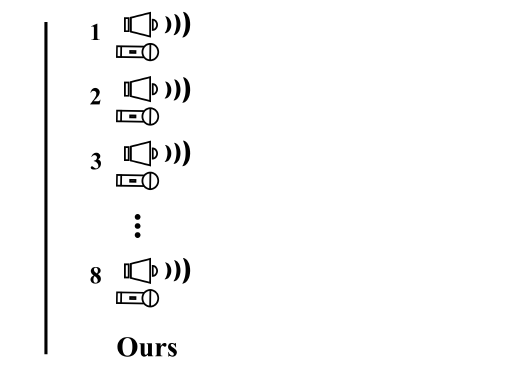
Figure 2. Comparison of the data collecting methods used by our acoustic system and the acous- tic